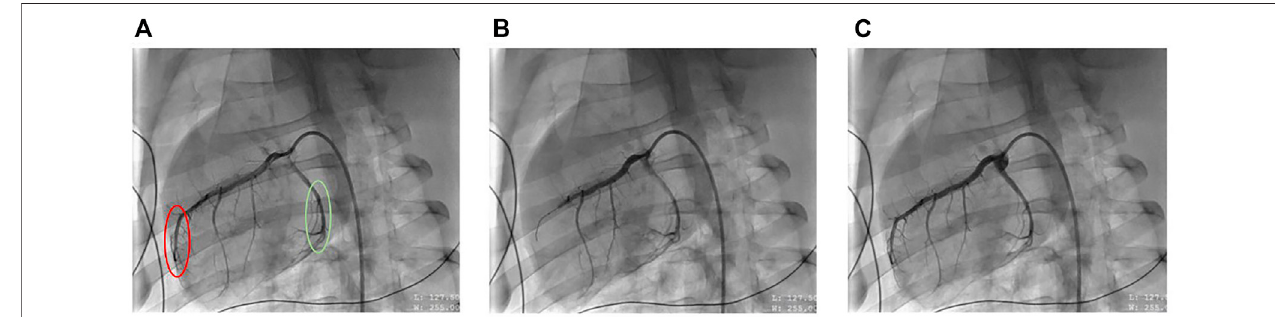
FIGURE 1 | Representative X-ray fl uoroscopic images of coronary artery blood fl ow before (left), during (middle) and after (right) mid-left anterior descending (LAD) arteryocclusion,resultinginST-elevationmyocardialinfarction (STEMI) (A) represents theporcineheartatbaseline wheretheredcircledenotestheischemic LADartery region,and thegreencircle denotesnon-ischemiccircum fl exartery region. (B) represents the heartwhen theLAD isoccluded, causingischemia and (C) representsthe heart after balloon de fl ation, resulting in